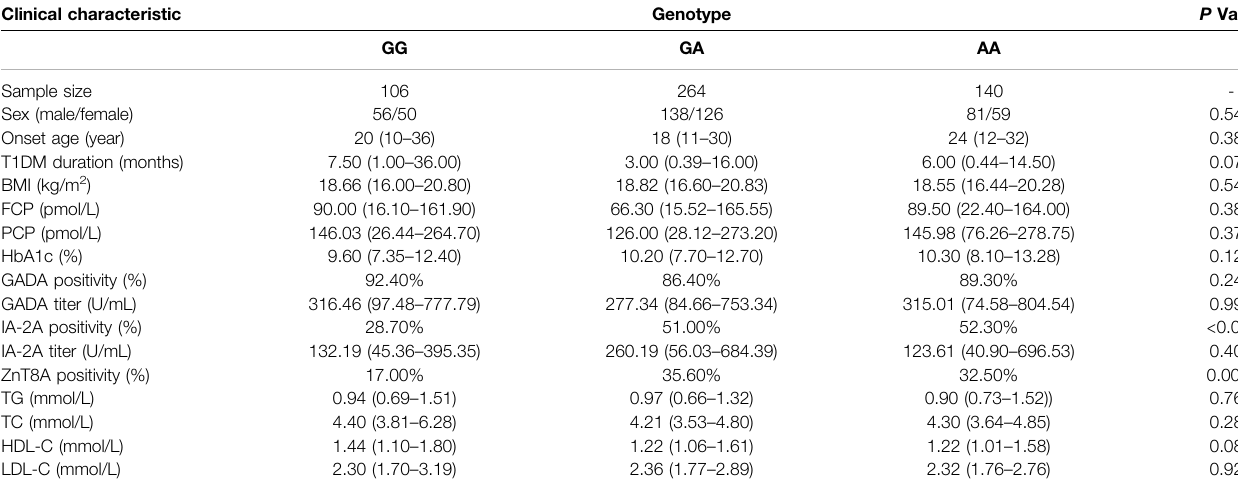
TABLE 5 | Clinical characteristics of participants with T1DM with different genotypes of rs1143627. Clinical